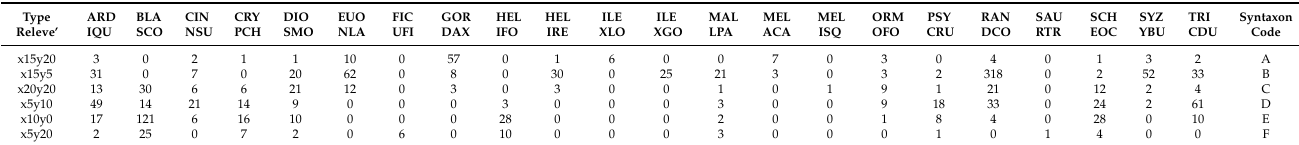
Table 4. Characteristic species data of the nomenclature type relev é